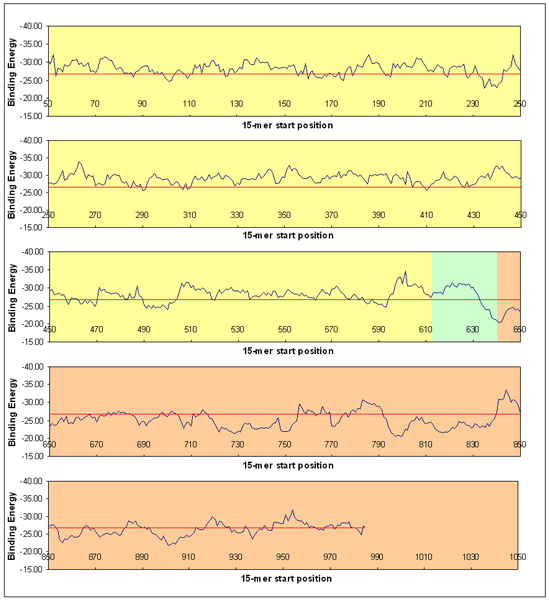
Predicted DRB1*0402-specific T-cell epitope repertoire within Dsg3. Location of predicted DRB1*0402-specific T-cell epitopes along the Dsg3 glycoprotein – extracellular domain (colored yellow; Dsg3 50–615), transmembrane region (colored green; Dsg3 616–640), and intracellular domain (colored pink; Dsg3 641–999). The red line indicates decision threshold -26.64 kJ/mol for high-affinity binders (SP = 0.80, SE = 0.65).